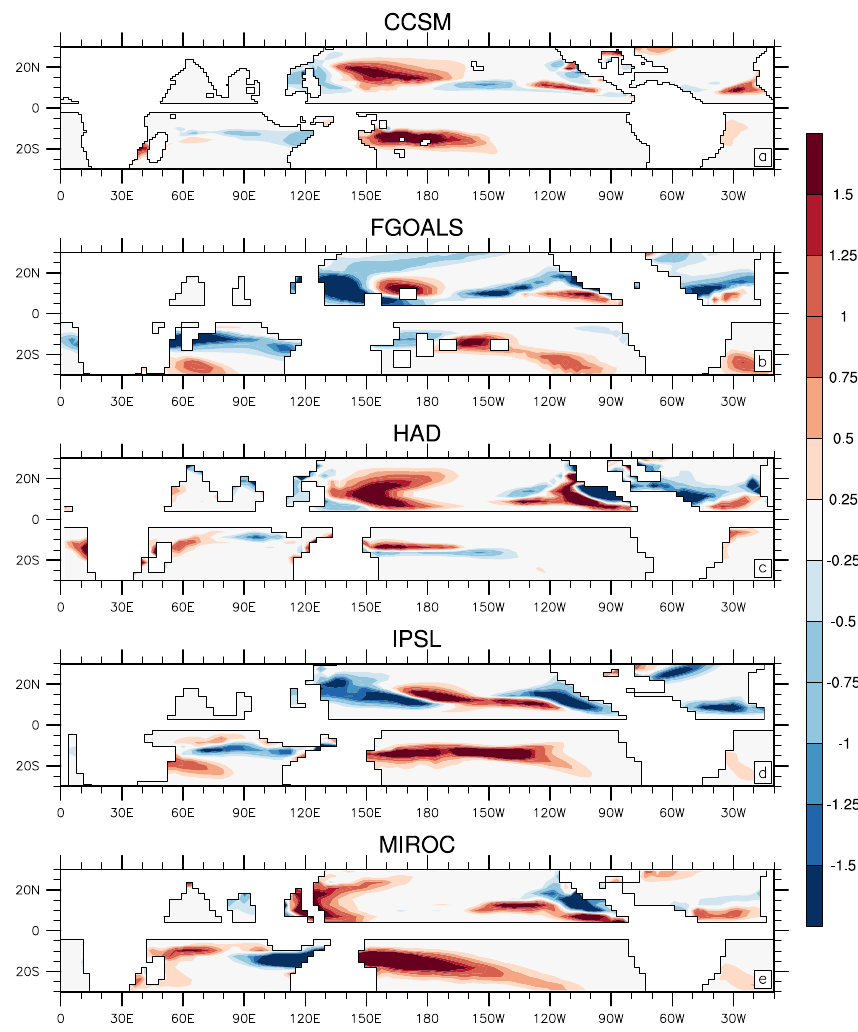
Figure 5. The difference in genesis potential index between LGM and preindustrial period in the Northern Hemisphere (JASO) and the Southern Hemisphere (JFMA) for (a) CCSM4, (b) FGOALS, (c) HadCM3, (d) IPSL, and (e) MIROC-ESM. Units are 10 − 13 normalised occurrences m − 2 month − 1